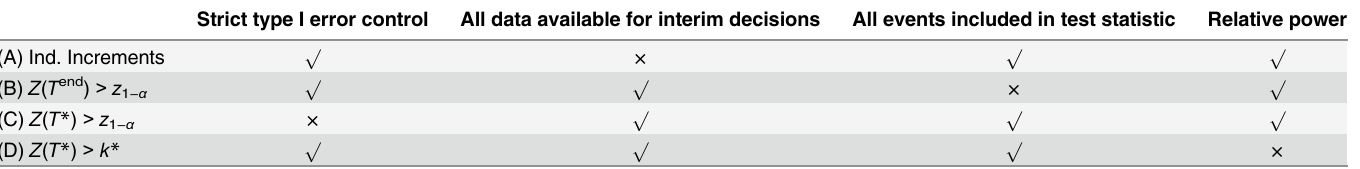
Table 2. Trade-off involved in choosing between methods when extending the follow-up period of a survival trial. Methods considered: (A), data is combined assuming independent stage-wise increments; (B), patient-wise separation with pre-fixed end of first-stage follow-up; (C), naive patient-wise sepa- ration without pre-fixed end of first-stage follow-up; and (D), patient-wise separation using the full-data guaranteed level- α test. Strict type I error